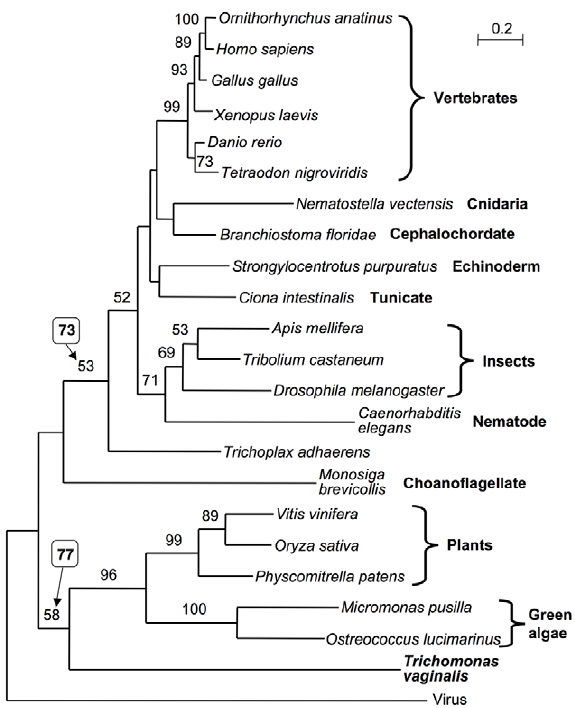
Figure 9. Phylogenetic analyses to maximize taxonomic diversity. Protein maximum likelihood phylogeny recovered for 23 TPasePL-GTases selected to maximize taxonomic diversity. The tree is rooted on the viral sequence and numbers indicate BP values . 50%. Boxed values indicate BP for corresponding analyses conducted without the iridovirus sequence (see Data S1, Figure S4). The scale bar indicates inferred number of substitutions per site.